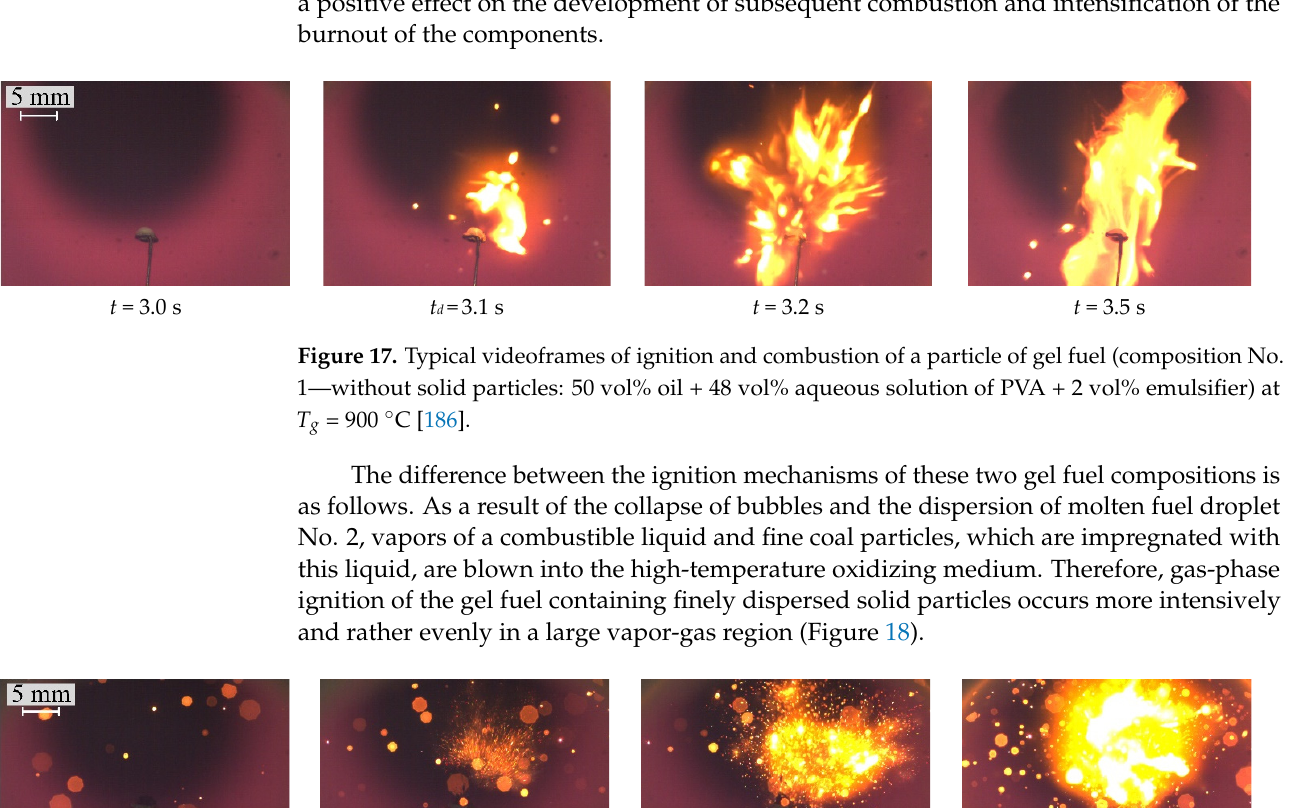
( b ) Figure 19. Characteristics of the dispersion of melts of gel fuels No. 1 and No. 2 at different rates of injection of fuel particles into the combustion chamber: ( a ) Speeds of movement of finely dis- persed fragments during droplet dispersion [186]; ( b ) Dimensions of areas in which the process of burnout occurs [186,187]. Under such conditions, for an oil-filled cryogel without solid inclusions, the average velocities of fine particles after dispersion change from 1.1 to 2.2 m/s (by 90–100%), for a fuel composition, with addition of carbonaceous particles, ranging from 1.6 to 2.5 m/s (by 45–55%). The authors found (Figure 19b) two different trends in the dependence of the size of the burnout area on the temperature of the energy source. Compositions with a conspicuous gas-phase combustion without dispersion of a droplet melt (Figure 19b— No. 3: with the addition of 30 wt% V-ALEX 100 aluminum nanopowder to the primary oil